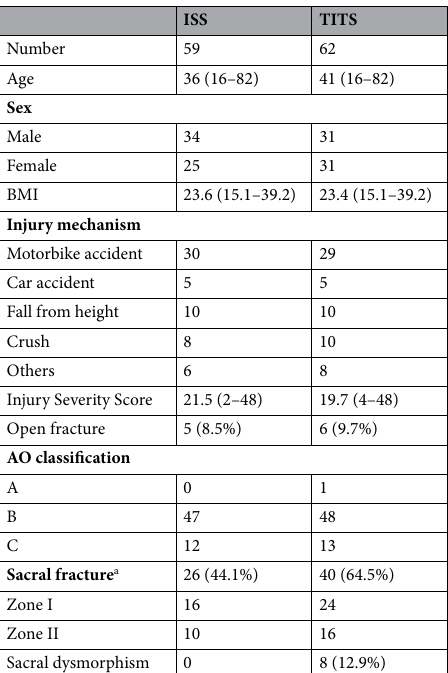
Table 2. Demographic data of the patients who underwent percutaneous iliosacral screw (ISS) and trans-iliac trans-sacral screw (TITS) fixation. BMI body mass index, AO Arbeitsgemeinschaft für Osteosynthesefragen. a Denis